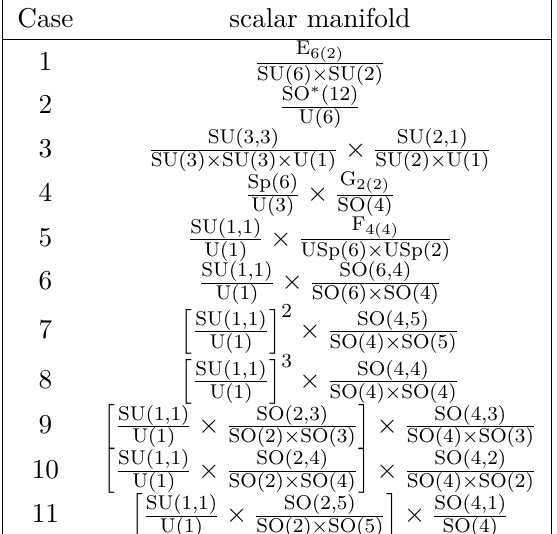
Table 2 . Scalar manifolds of the truncated theories.